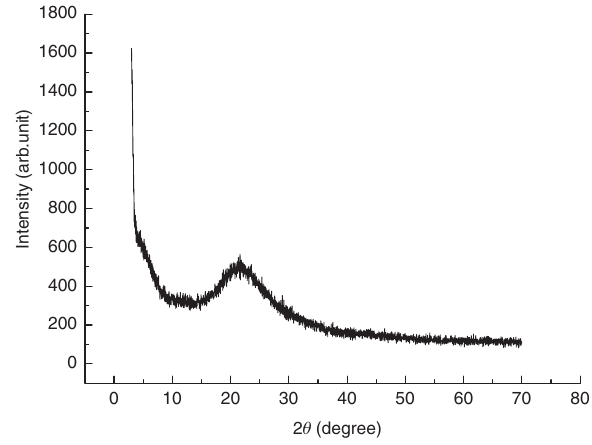
Figure 7 XRD pattern of modified nano-silica powder.